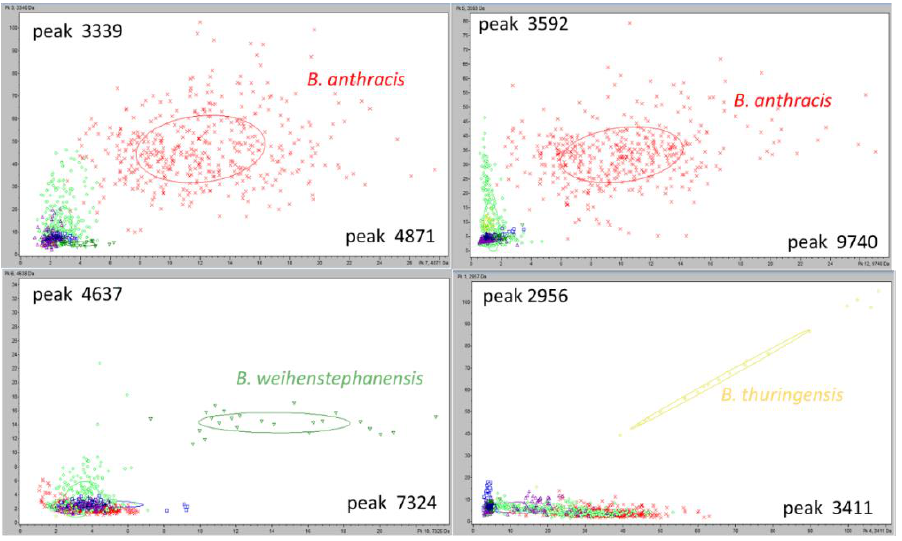
Table 2. Results of ClinProtools statistical model quick classifier (QC) and Support Vector Machine (SVM) in terms of Recognition Capability and Cross Validation for overall and single Bacillus spe- cies considered.